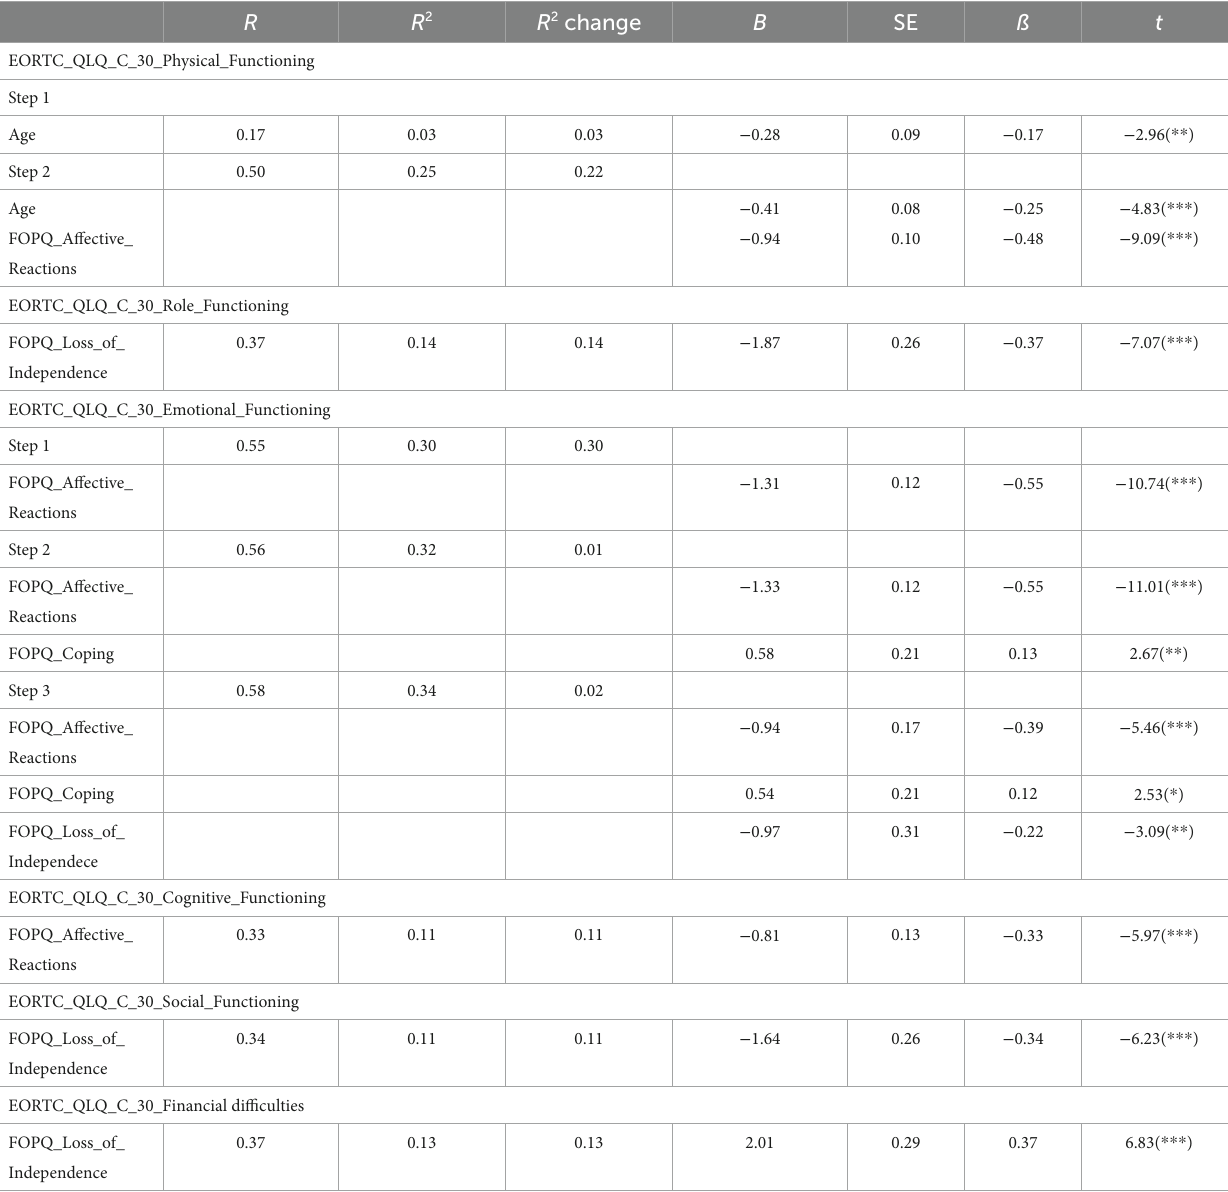
TABLE 4 Hierarchical regression model of the components of Subjective quality of life as criterion variables, with demographic variables (age, gender, marital status, stage of illness), and the components of fear of cancer progression as